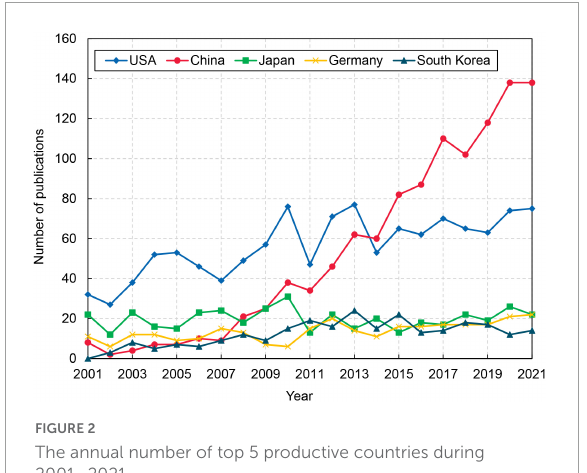
FIGURE2 The annual number of top 5 productive countries during 2001–2021.